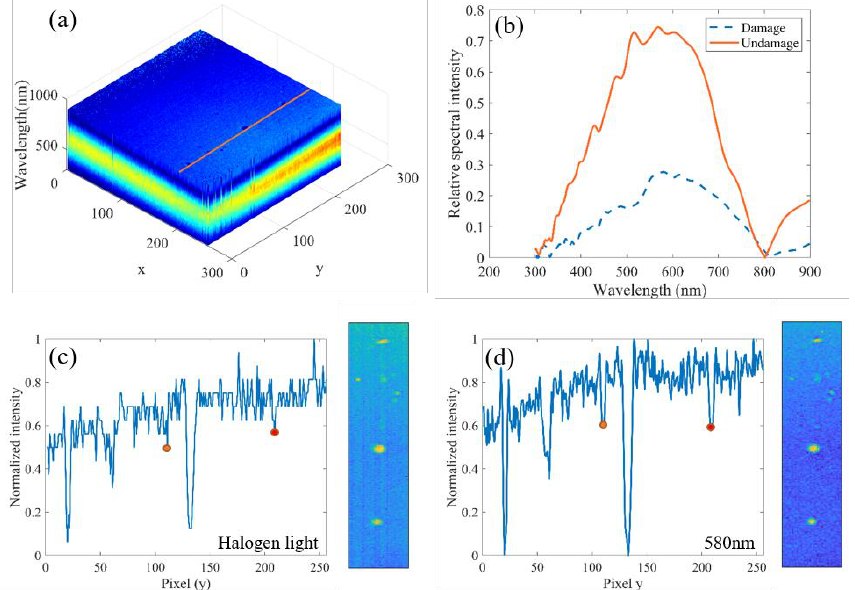
Figure 10. ( a ) Hyperspectral data cube of K9 glass. ( b ) The spectra of damaged and undamaged points. ( c ) From left to right, one-dimensional (x = 203) and two-dimensional (x = 200 – 240) spatial information for the entire spectrum. ( d ) From left to right, one-dimensional (x = 203) and two-dimensional (x = 200 – 240) spatial information at the indicated wavelengths (580 nm).